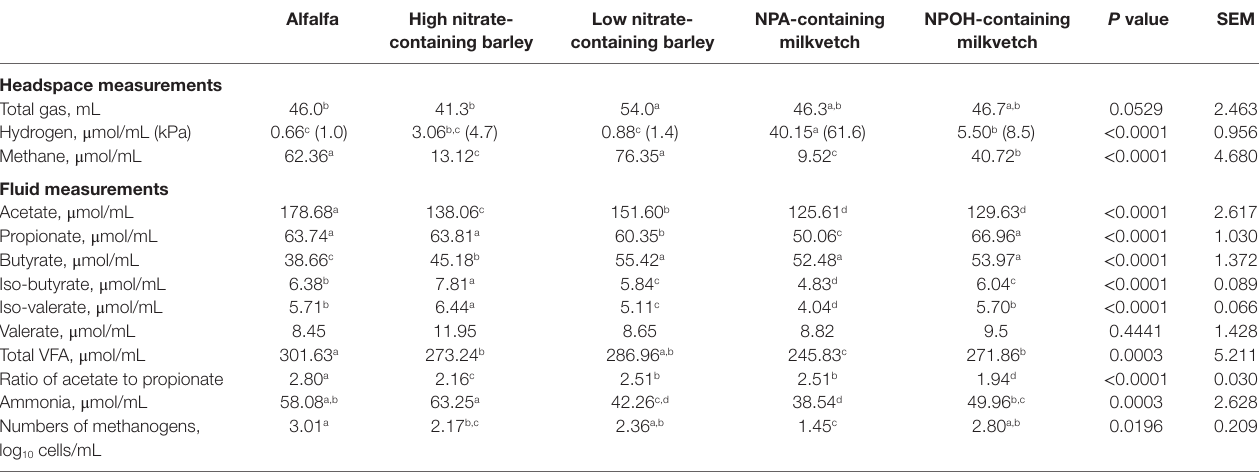
TaBle 2 | Fermentation characteristics of alfalfa and select nitrate- and nitro-containing forages during incubation with mixed cultures of ruminal microbes in experiment 1 with 50 mM added sodium formate, but without inoculation with Denitrobacterium detoxificans . alfalfa high nitrate- low nitrate- nPa-containing nPOh-containing containing barley containing barley milkvetch milkvetch headspace measurements Total gas,